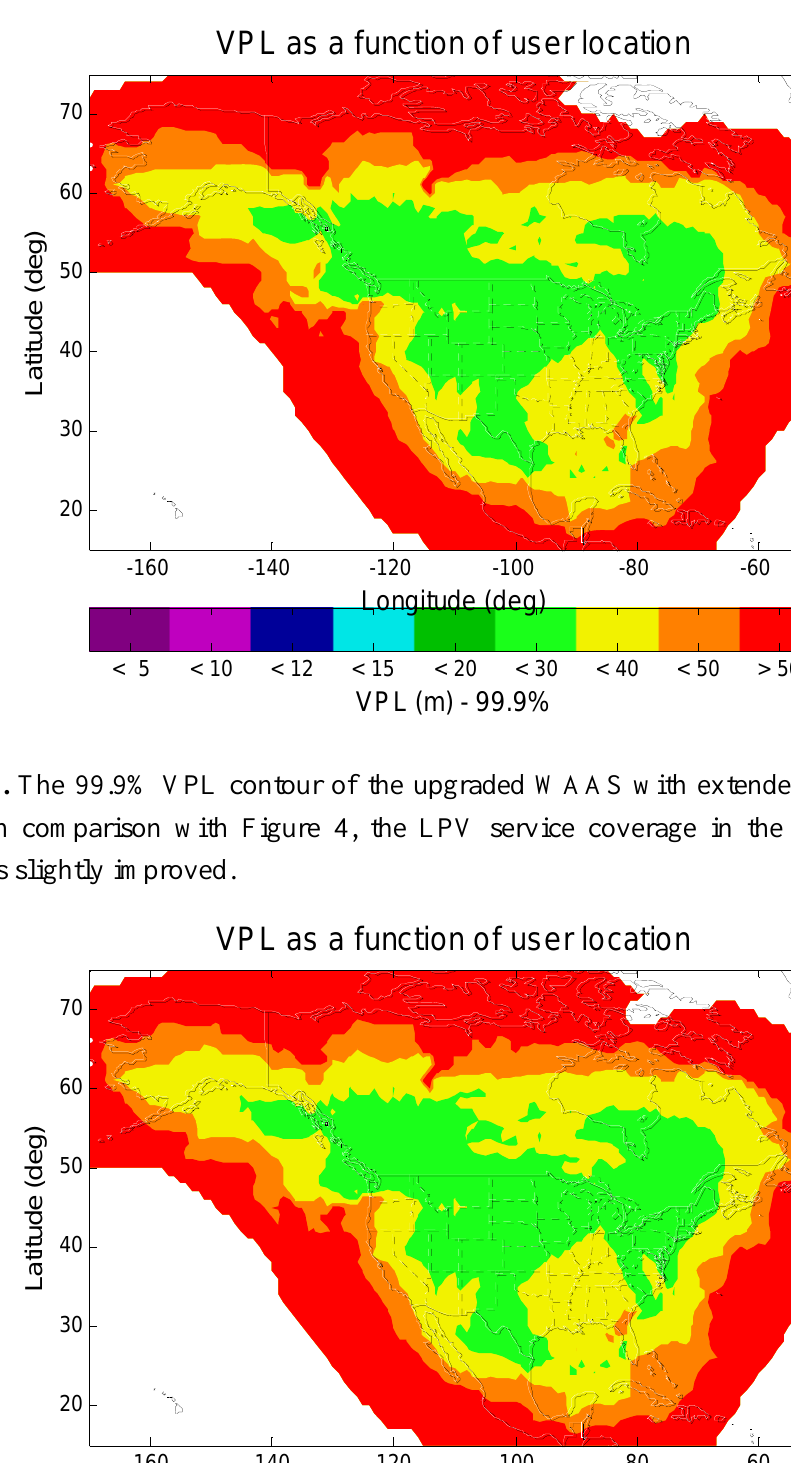
Figure 4. The 99.9% VPL contour of the upgraded WAAS with more IGP in Alaska. In comparison with Figure 3, the LPV service coverage in Alaska is improved.